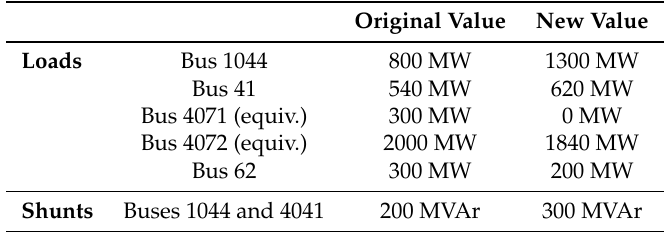
Table A2. Modifications of Nordic32A